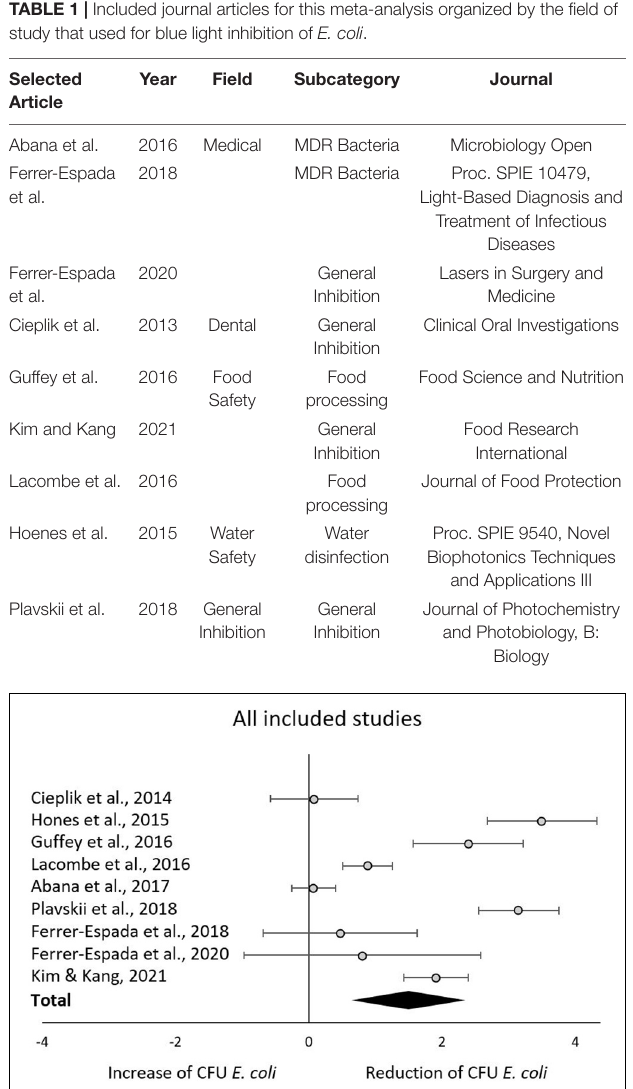
FIGURE 3 | Forest plot of reduction of E. coli post blue light exposure in all included